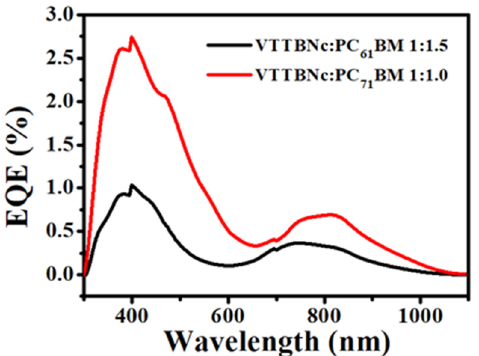
Figure 11. External quantum efficiency (EQE) as a function of wavelength for VTTBNc:PC 61 BM 1:1.5 and VTTBNc:PC 71 BM 1:1.0.